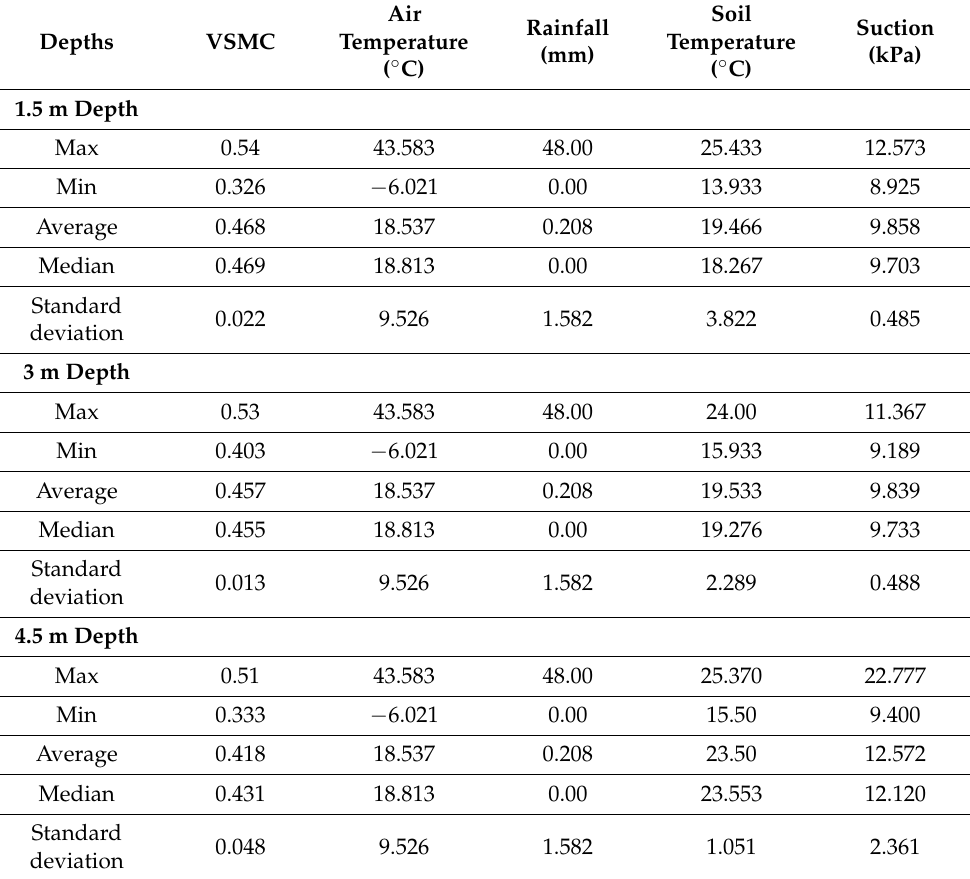
Table A3. Preliminary Detailed Statistics for the constructed dataset HWS